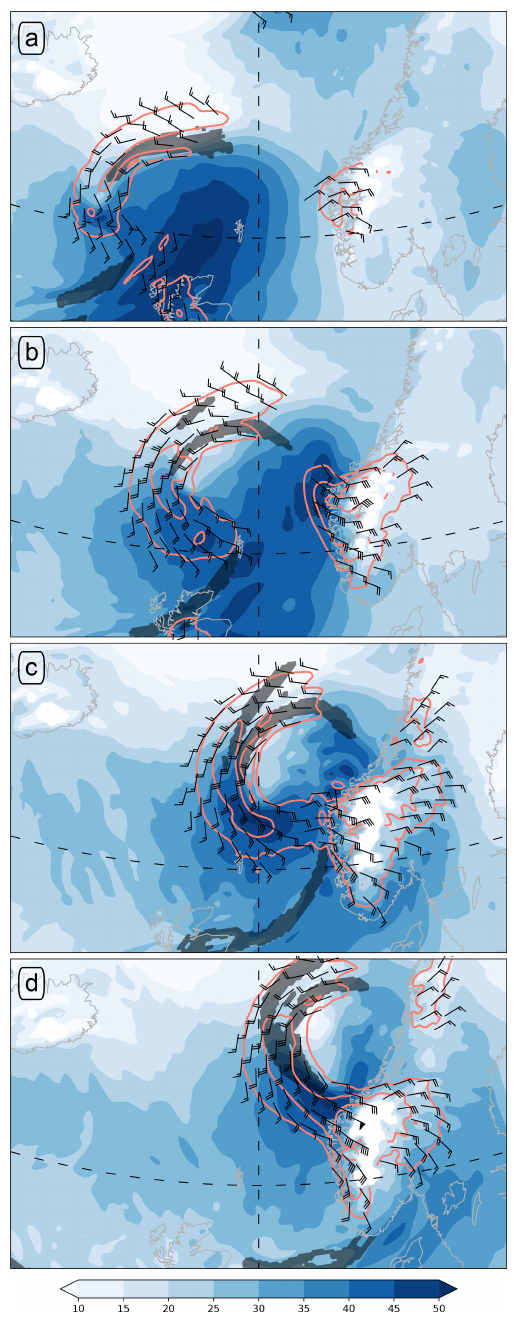
Figure 3. Full wind speed (ms − 1 ) at 850hPa in the NORA10 hindcasts at (a) 00:00UTC, (b) 03:00UTC, (c) 06:00UTC, and (d) 09:00UTC on 1 January 1992. Barbs and pale red contours show ageostrophic wind with contours at 15, 25, and 35ms − 1 . Dark shared regions show the location of front volumes at 850hPa as in Fig.